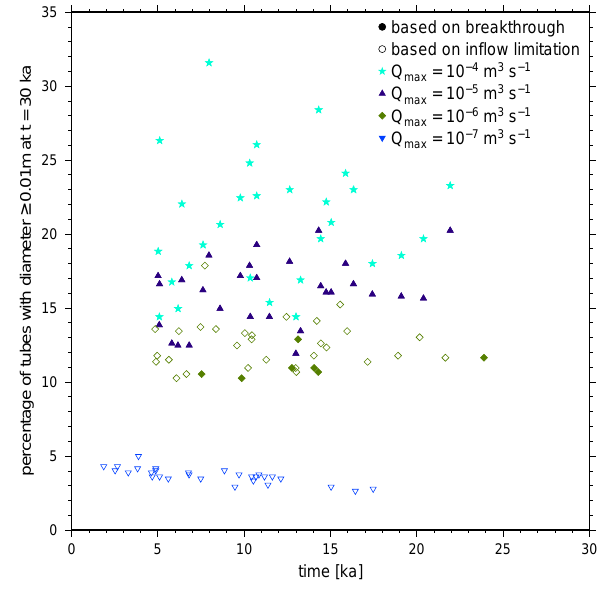
Fig. 6. Temporal evolution of the mean aperture distribution of the low-heterogeneity model with total maximum recharge Q max = 10 − 4 m 3 s − 1 .